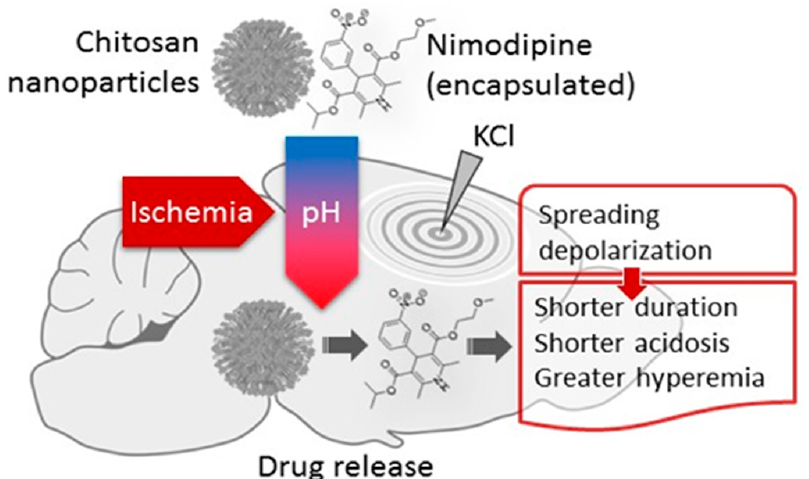
Figure 5. Nimodipine delivered with pH-responsive chitosan nanoparticles to the cerebral cortex suppressed spreading depolarization (SD) and augmented the hyeremic element of the associated CBF response in a rat incomplete global forebrain ischemia model. Reprinted from Tóth, M. et al., 2020 [77], with permission from Elsevier.